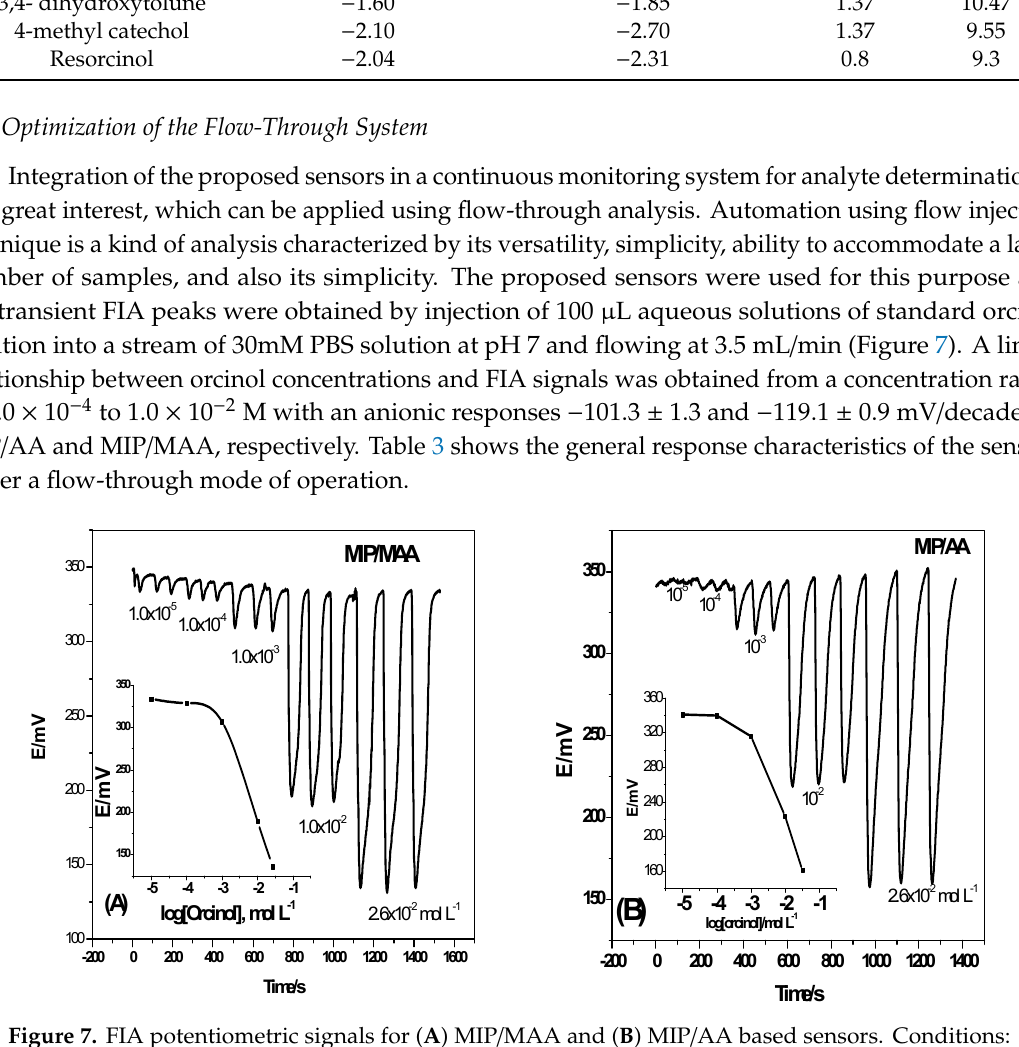
Figure 7. FIA potentiometric signals for ( A ) MIP/MAA and ( B ) MIP/AA based sensors. Conditions: carrier solution, 30 mM PBS pH 7, flow rate 3.5mL/min. Table 3. Response characteristics of orcinol sensors using flow injection analysis in 30 mM PBS at pH 7.